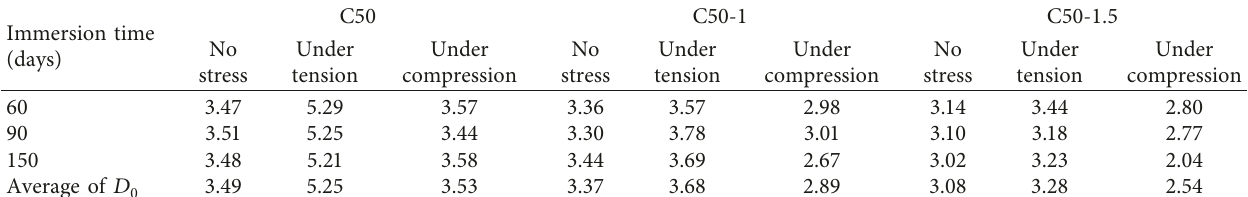
Table 4: Results of k